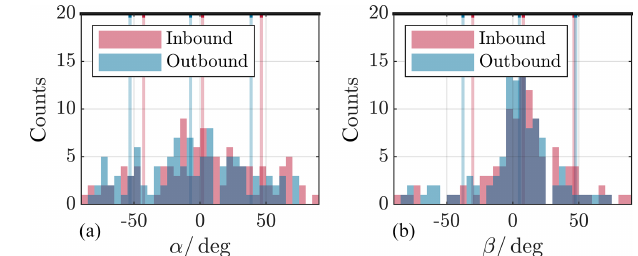
Figure 11. Deviation angle between model and data normal direc- tion as projected onto yz GSM plane (polar plane) (a) , and as pro- jected onto xy GSM plane (equatorial plane) (b) , for the innermost crossings. The distributions are separated by inbound (red) and out- bound (blue) passes. Indicated by the coloured vertical lines are the respective median angles as well as the standard deviations; see text. The meaning of the angle sign is explained in Fig. 8.